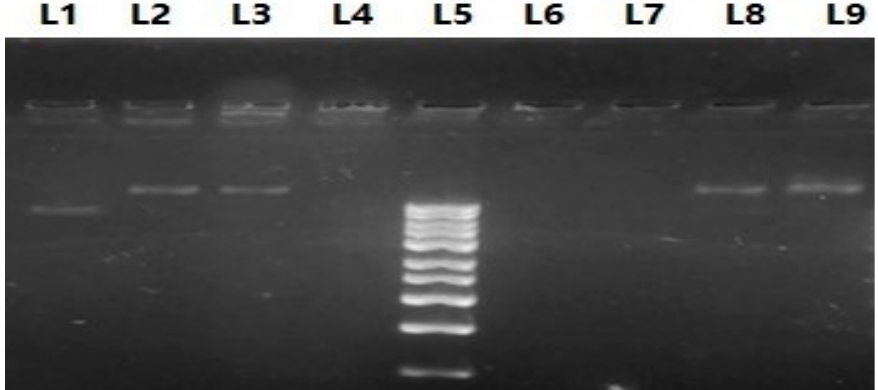
Figure 4. Gel electrophoresis of treated and untreated NmC cells. A photo of agarose gel showing the DNA contents of BG cells (Lanes 6, 7), untreated bacterial cells (Lanes 8, 9), and supernatant of BG culture (Lanes 1–3) against 1 Kbp Ladder (Lane 5), empty lane to separate the DNA ladder from the samples (Line